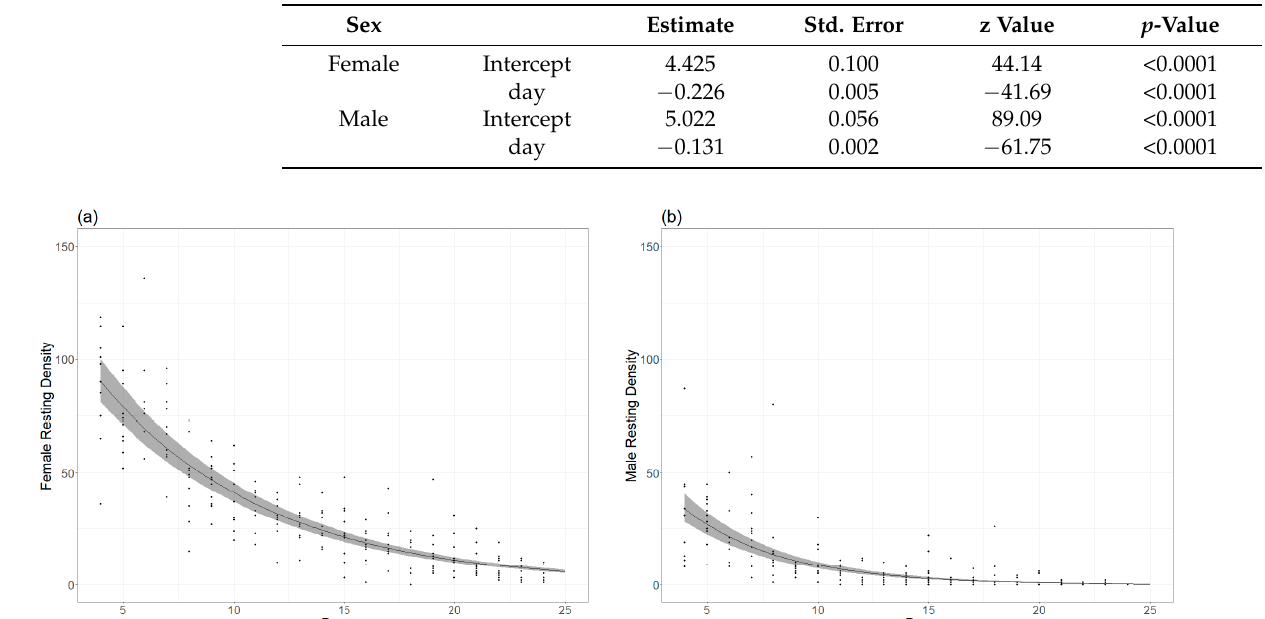
Table 2. Survival rate of males and females. Parameter estimates of model for the relationship between resting number of individuals over a 128-cm 2 surface versus time.